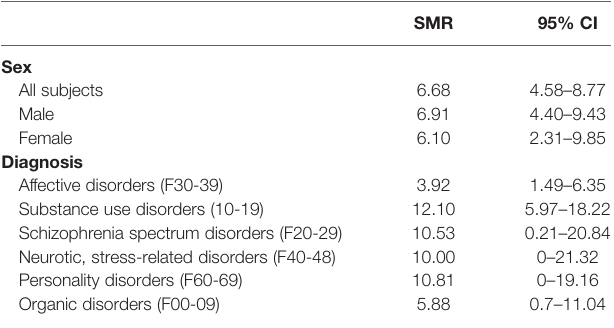
TABLE 4 | Standardized mortality ratios (SMR) and con fi dence intervals (95% CI) of all patients and strati fi ed by sex and